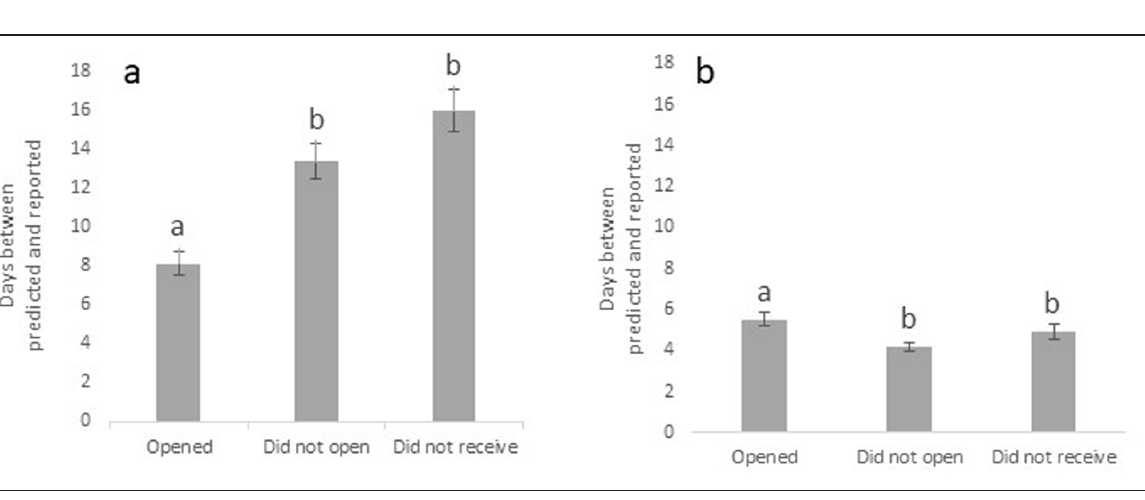
Table 1 Summary of leaf-out and bloom messages opened, received but not opened, and not received by lilac observers in 2018, 2019, and 2020. Email message open rate provided in (%); these rates are calculated as the percentage of individuals receiving the messages that opened